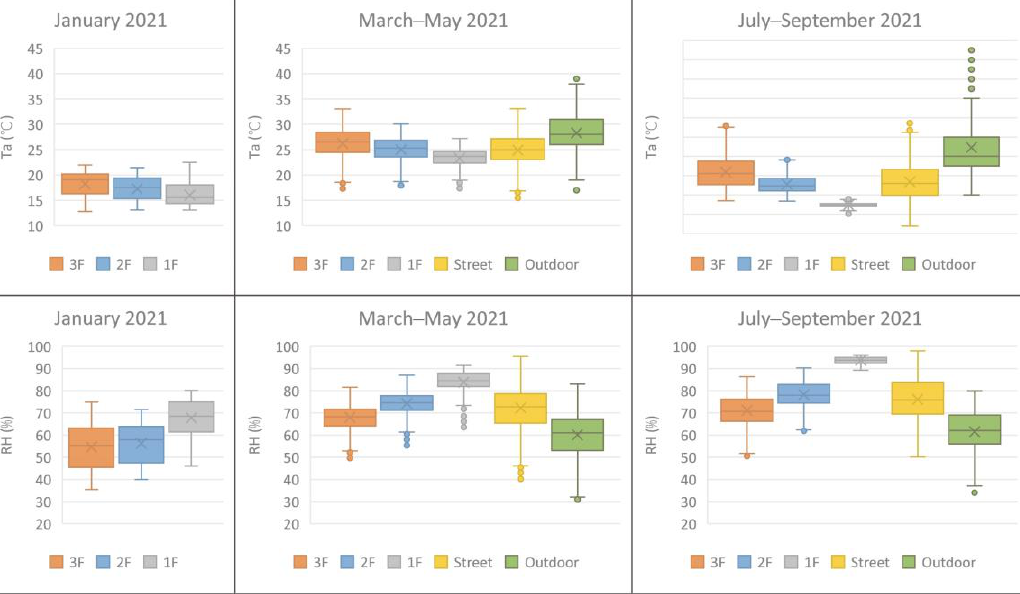
Figure 16. Tg measurement data (March – September 2021), drawn by the students.